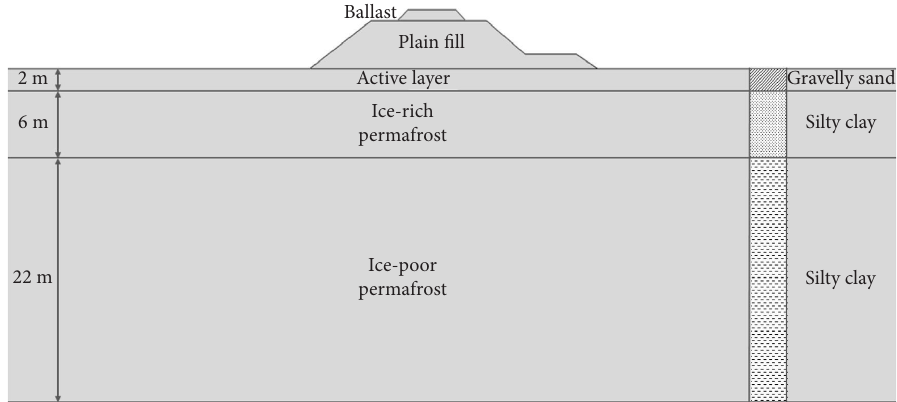
Figure 2: Te cross-section profle and the soil layer structure of a typical traditional embankment.